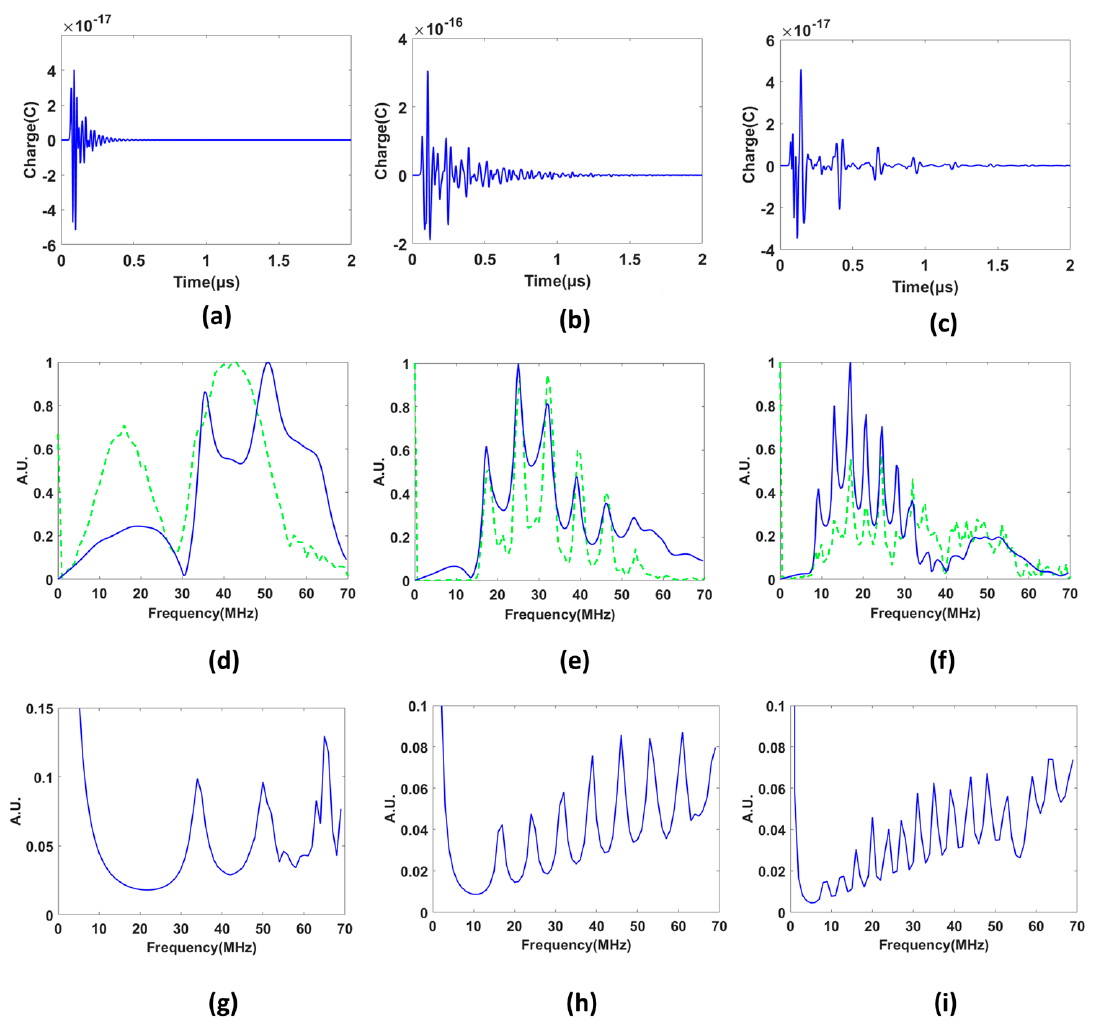
Figure 5. Simulated receiver signals for the laser excited (photoacoustic) pulses in the time-domain from the ( a ) PS20, ( b ) PS40, and ( c ) PS80 microparticles. The corresponding amplitude spectra for the COMSOL simulations are shown with solid blue lines in ( d – f ), respectively, with the experimental spectra for data 1 with the green stippled curves overlayed for comparison with simulated results in blue. In these figures, all spectra have been individual normalized with respect to their maximum values. The lower figures ( g – i ) shows the simulated frequency responses for PS20, PS40 and PS80, respectively.